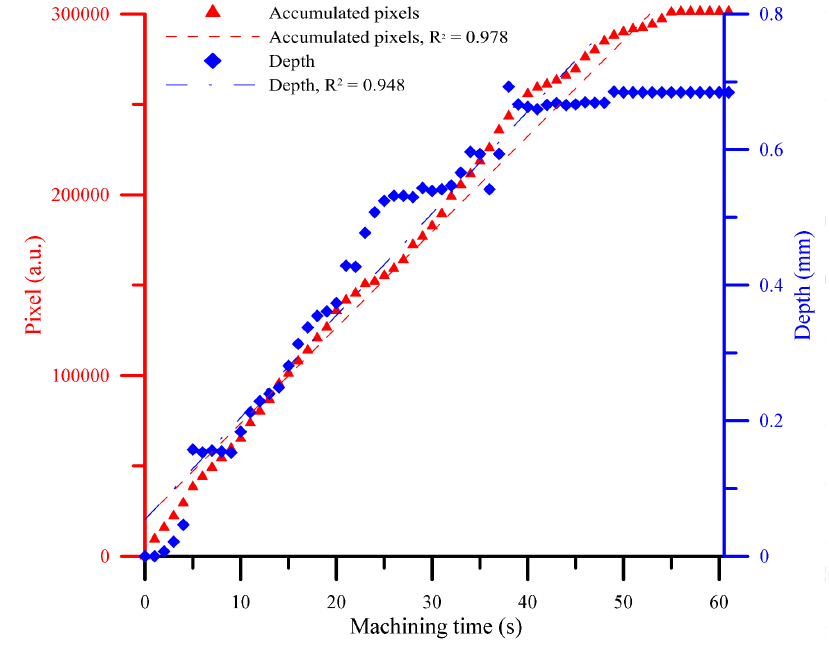
Figure 11. The correlation between pixels and deepness relative to the drilling